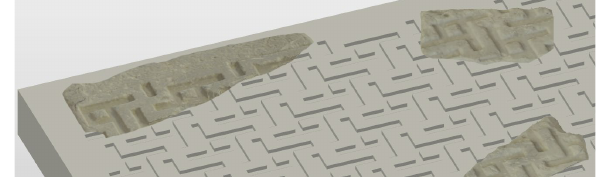
Figure 10. 3D modelling integration